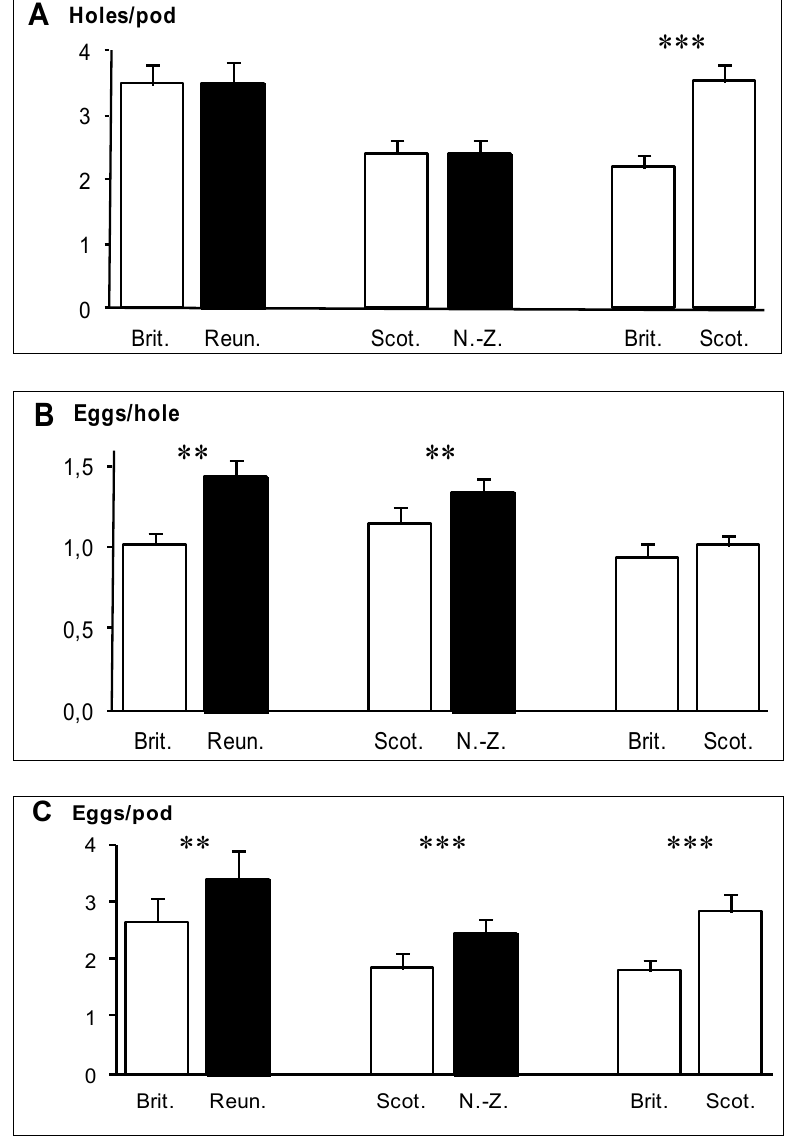
Figure 2. ( A ) Mean number of holes bored by the weevils E . ulicis through the pod walls of U . europaeus ; ( B ) mean number of eggs laid per hole; ( C ) mean number of eggs per pod ( C ). White bars: native regions, black bars: invaded regions. Means are shown with 1